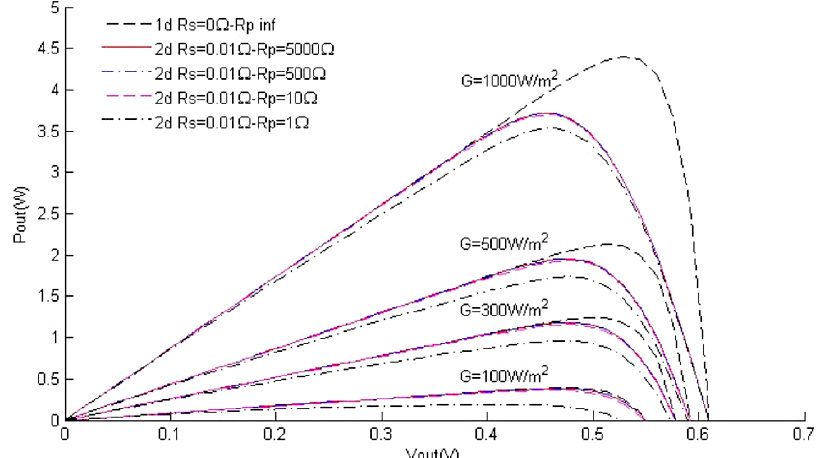
Figure 9. I - V curves of equivalent 1 and 2 diode circuits in function of the solar radiation and of the parallel resistance R p , with series resistance R s constant (T = 25 ◦ C).